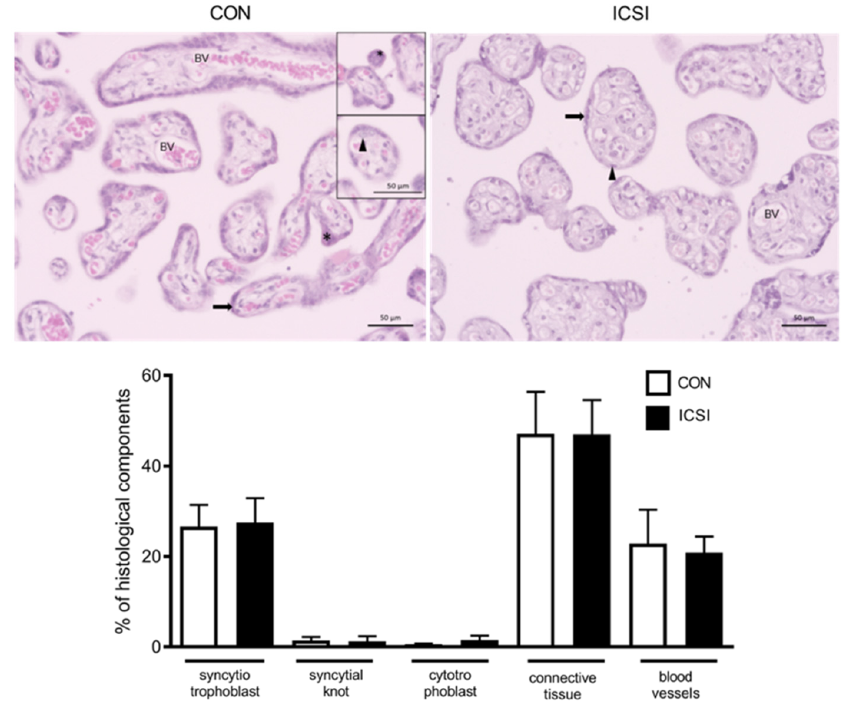
Figure 5. ICSI does not alter placental volumetric proportion. Representative histological photo- micrographies of control naturally conceived (CON; n = 10) and ICSI ( n = 11) placentae and correspondent volumetric proportion analyses of the number of syncytiotrophoblasts, cytotrophoblasts, connective tissue, blood vessels, and syncytial knots. Data presented as mean ± SD. p < 0.05. Arrows indicate the syncytium, arrow heads indicate cytotrophoblasts, indicate the syncytium knots and BV= blood vessels (fetal). Scale bar = 50 μ m.